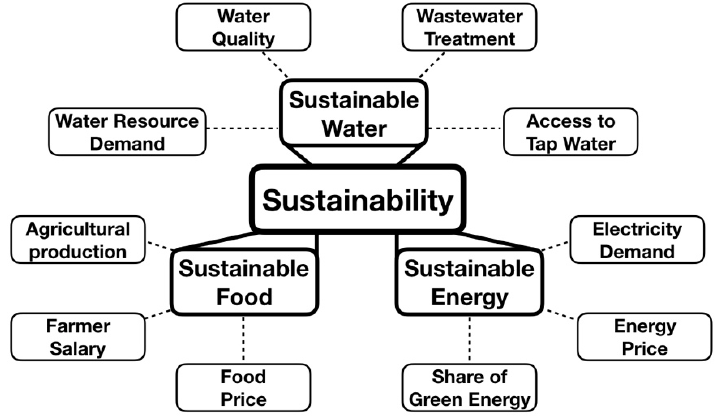
Figure 4. Sustainable water–energy–food (WEF) nexus.